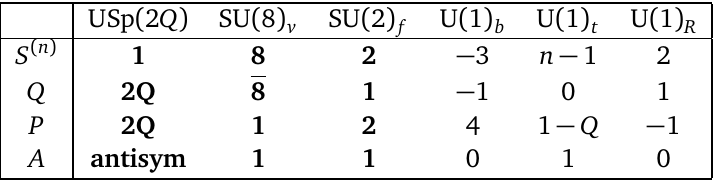
Table 1: The matter contents of the SU ( 8 ) × SU ( 2 ) × U ( 1 ) 2 model and their